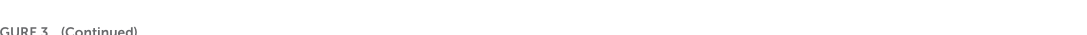
FIGURE3 (Continued) nucleus size of MSNs in Pitx3 cWT and Pitx3 cKO mice at 6 ( N = 4 mice per genotype; all males), 12 ( N = 4 mice per genotype; all males) and 18 months ( N = 3 mice per genotype; all males) of age. 2way ANOVA analysis with Sidak’s multiple comparisons test, ∗∗ p = 0.0075